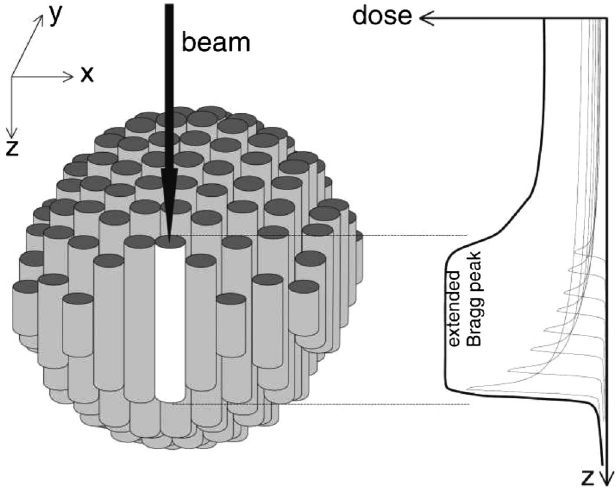
FIG. 1. Schematic principle of depth scanning with energy broadened ion beam (courtesy U.